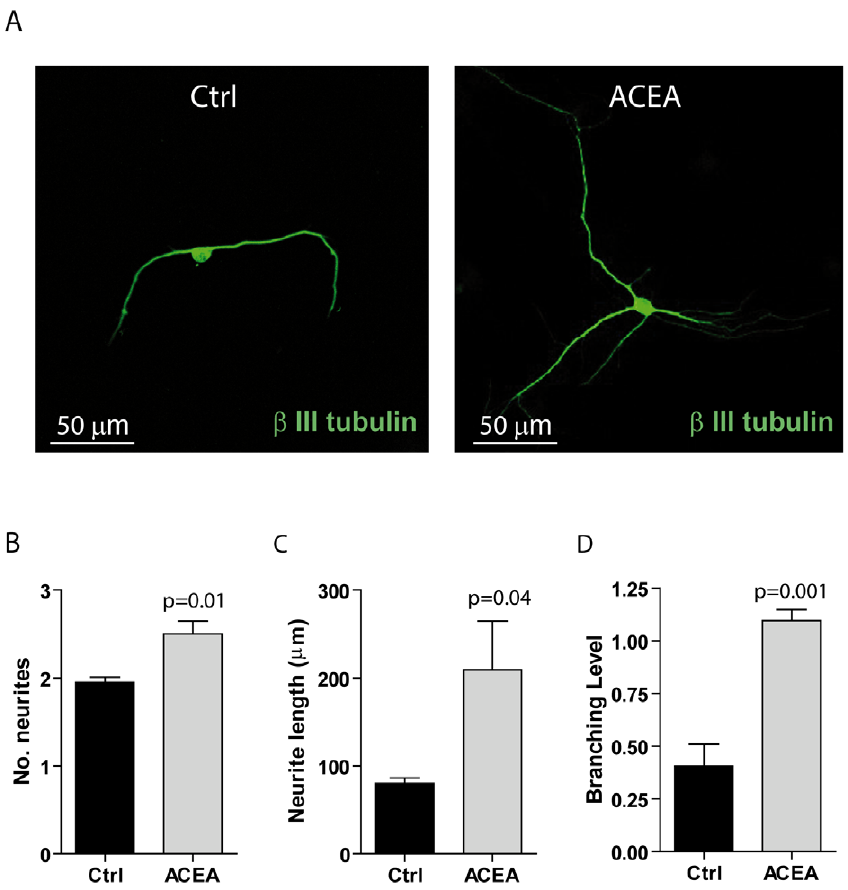
Figure 4. CB 1 receptor stimulation enhances maturation of the invitro differentiated neurons. ( A ) Representative images of the immunofluorescence analysis of b -III tubulin in cells differentiated from NSCs after three days of culture in 1% FBS in the presence or absence of 1 m M ACEA. ( B–D ) Bar graphs represent quantitative data of morphometric analyses of number ( B ), length ( C ) and branching level of neurites ( D ) in cells treated as described in ( A ). Data represent the mean 6 SD of 4 experiments. Statistical analysis was performed using the paired t-test; the p value is indicated above the individual samples.